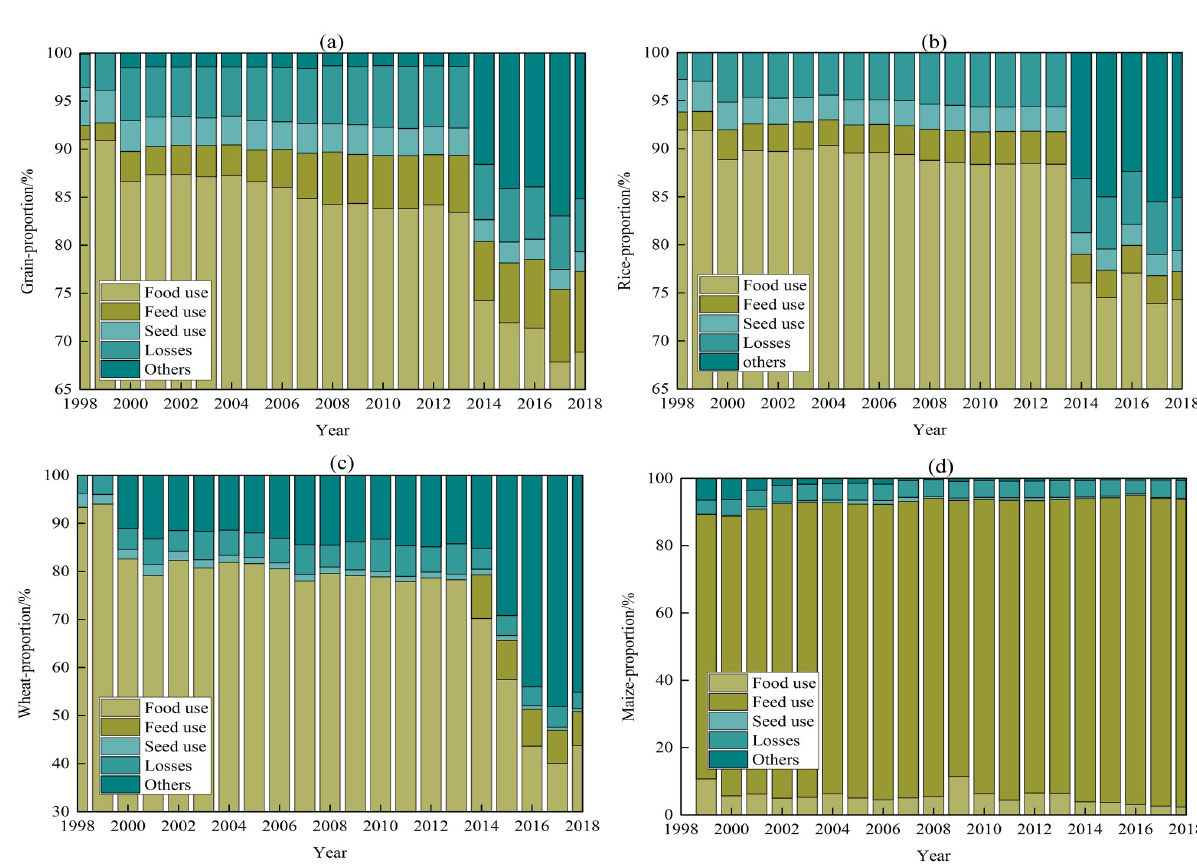
Fig 5. The proportion of demand for different uses of grain products in Bangladesh from 1998 to 2018. (a) Grain products, (b) Rice products, (c) Wheat products and (d) Maize products. The grain demand data for the years 1998–2013 and 2014–2018 are derived from the old and new FBS databases, respectively. The proportion of processing to total demand was too small to be shown in this